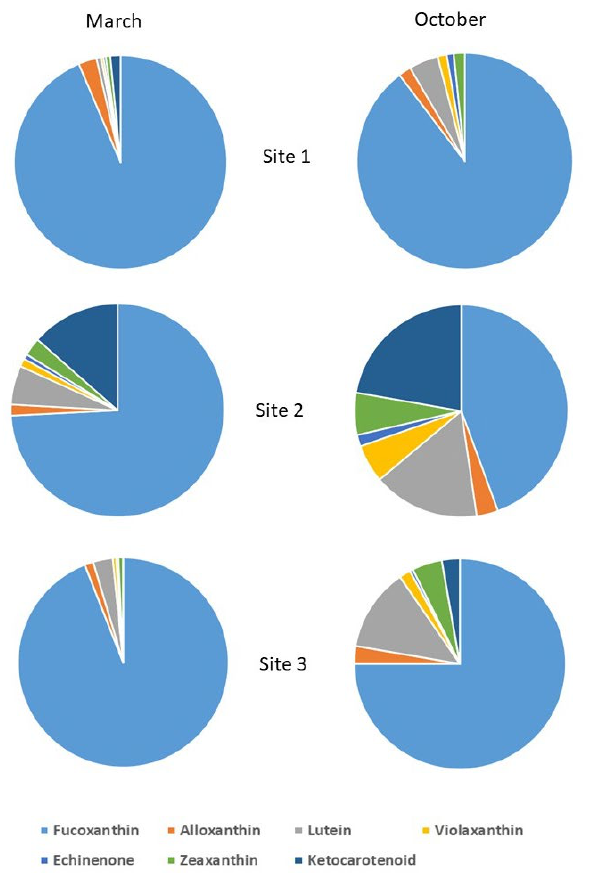
Figure 4. HPLC characterization of carotenoids in each biofilm sample. Carotenoids are reported in the legend with different colors. Site 1 (Villadossola), Site 2 (Bosco Tenso), Site 3 (Ornavasso).